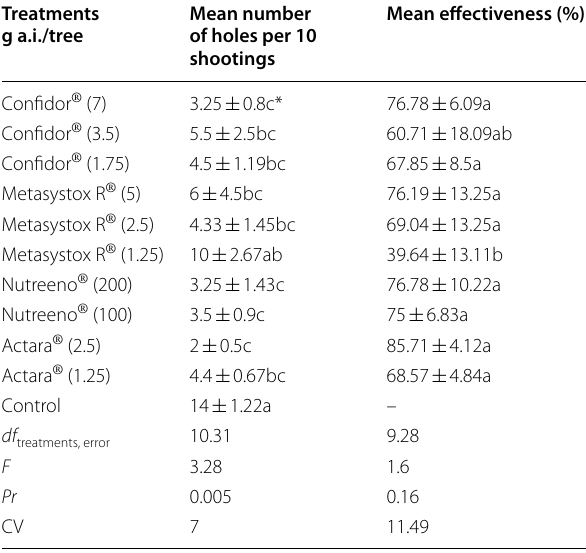
*Treatments by the same letter (s) in the columns are not significantly different after analysis using the Duncan test at 5% level